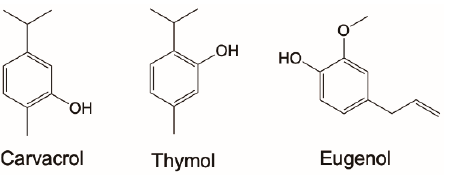
Figure 1. Phenolic components found in the investigated